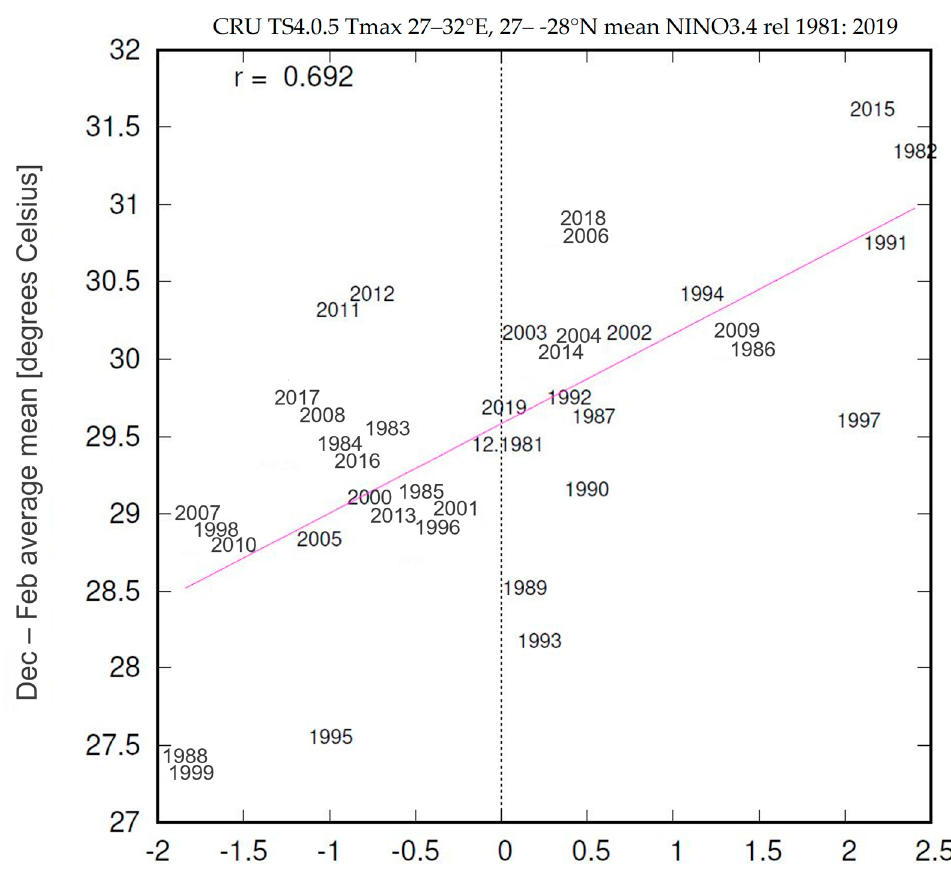
Figure 6. Austral summer, December–February (Dec–Feb), correlation of the Niño 3.4 sea surface temperature and maximum temperature over South Africa from 1981 to 2020.